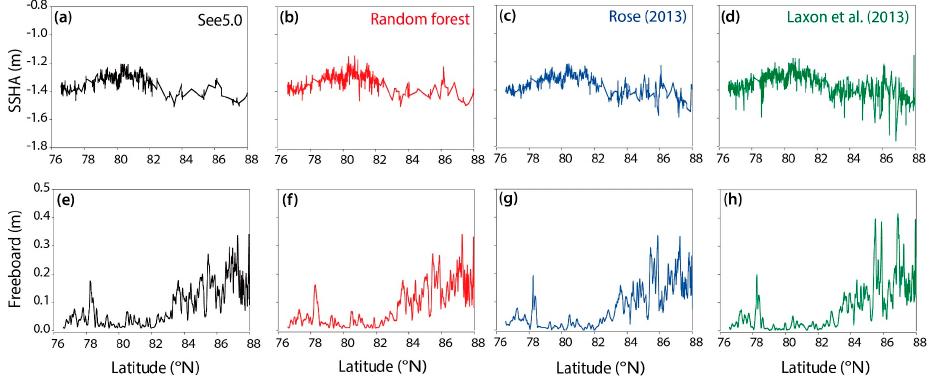
Figure 8. SSHA and freeboard extracted by each method using CryoSat-2 data from UTC 03:47–03:57, 9 April 2012 based on IC: ( a – d ) are the interpolated and smoothed SSHA; ( e – h ) the smoothed freeboard.